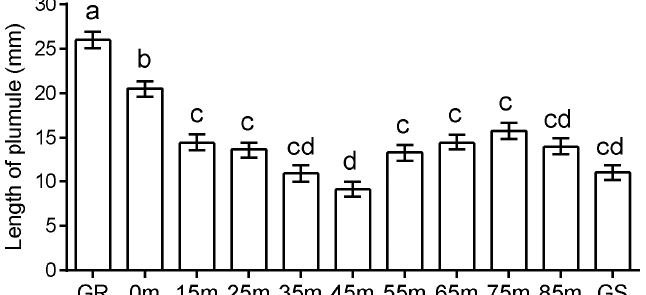
Figure 3. Glyphosate effects on plumule growth of progenies of pollen receptor plants (spaced from 0 to 85 m from the glyphosate-resistant plants as the source of pollen), glyphosate-resistant plants (GR, positive control), and isolated glyphosate-susceptible plants (GS, negative control). Bars indicate mean values, error bars represent ±1 standard error, and bars with the same letters are not significantly different ( p > 0.05; Tukey’s HSD test).